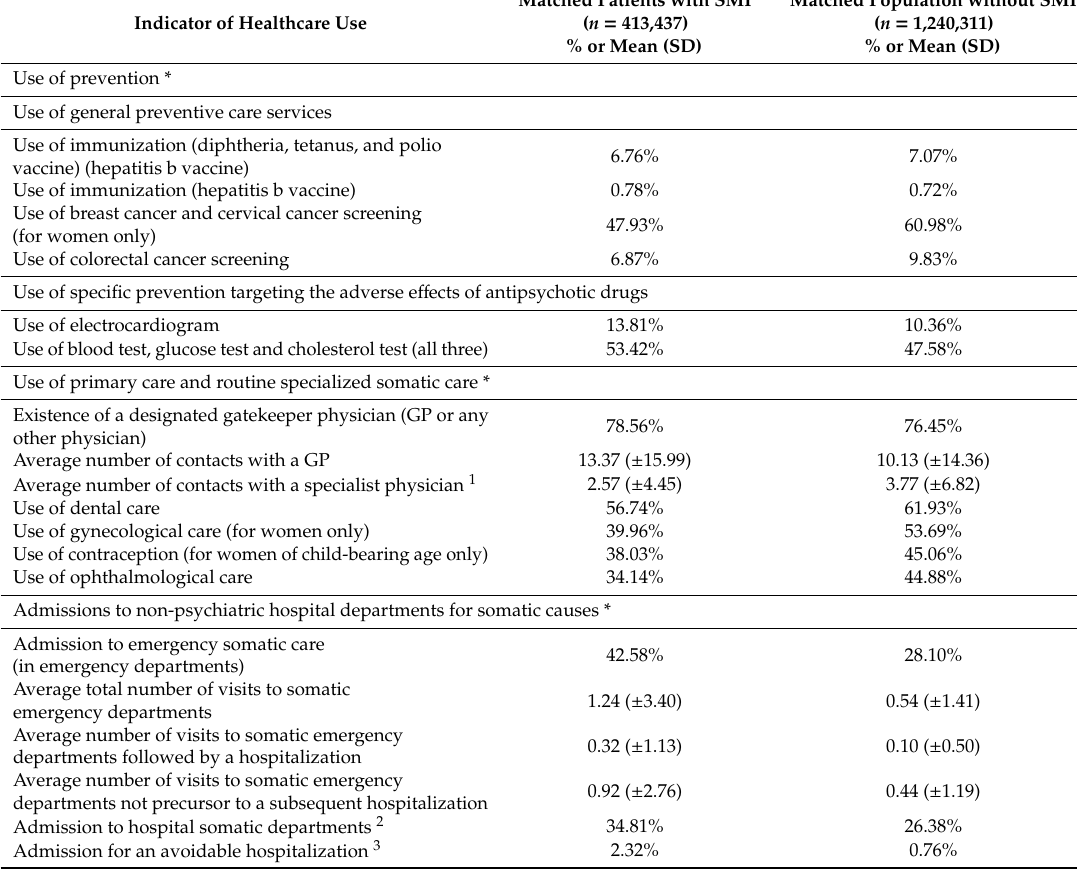
Table 3. Univariate analysis of general somatic care use in patients with SMI compared with matched controls without SMI. Indicator of Healthcare